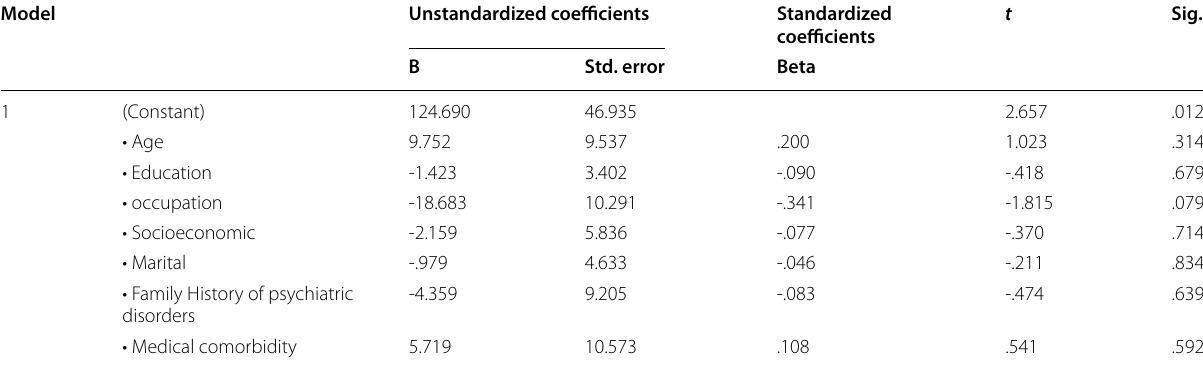
Table 2 Coefficients a and oxytocin